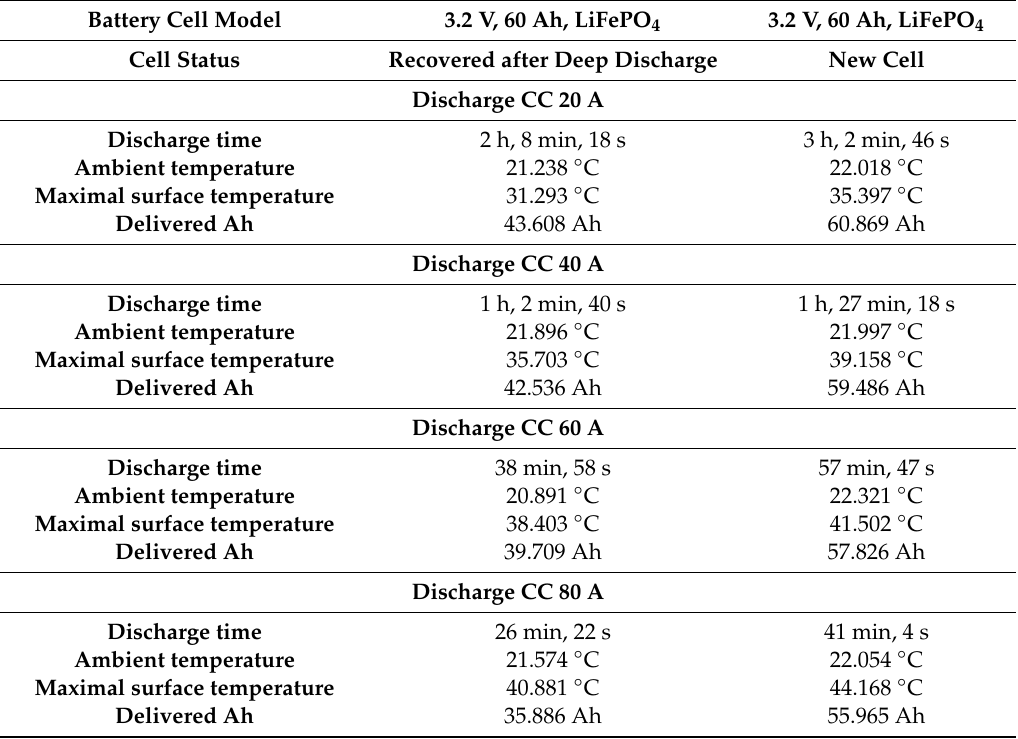
Figure 18. Voltage profile during discharge by 60 A ( left ) and 80 A ( right ) for regenerated (yellow) and referenced cell (green). Table 6. Summary of the results of the verification test of deeply discharged